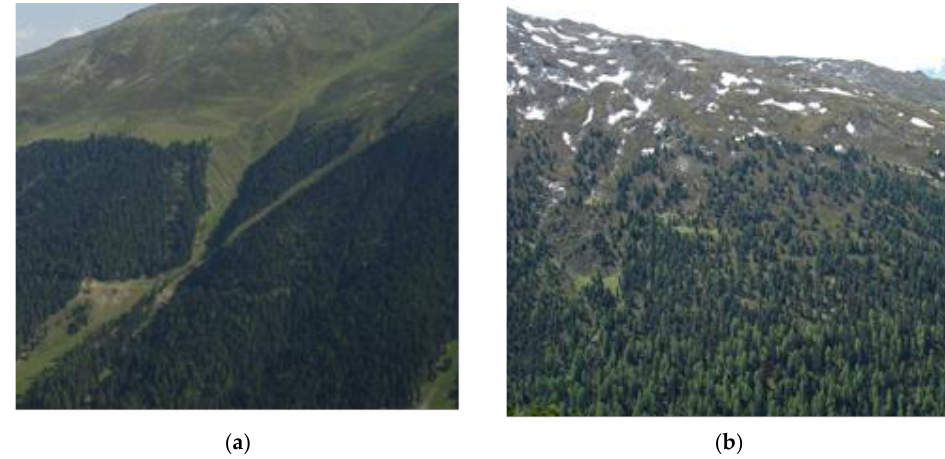
Figure 1. Sharp ( a ) versus diffuse ( b ) treeline in the Tyrolean Alps at 2100 – 2200 m a.s.l. The sharp treeline formed by Pinus cembra in the Radurschltal shows only little signs of opening towards their upper limit, whereas the diffuse treeline composed of Pinus cembra and Larix decidua in the Tuxer Alps is gradually opened by avalanches and due to century long pastoral use.